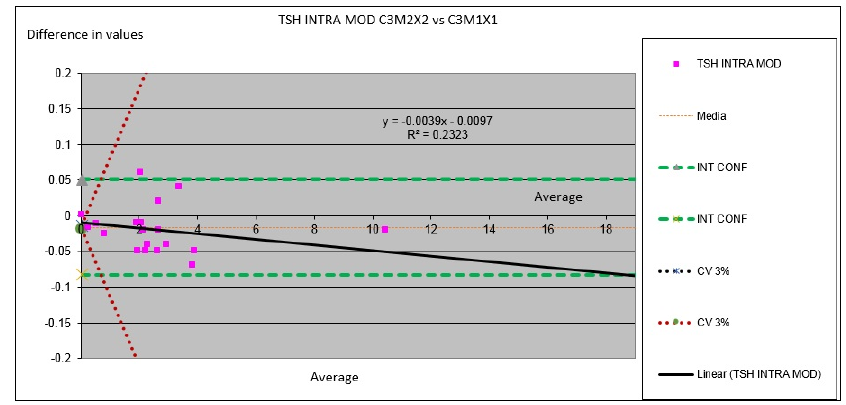
Figure 6. Comparison between modules for the TSH parameter in which it have compared the results obtained by the measurements performed in the two machines (Analyser C3 substituted by C2 in which the Module 2 is substituted by the module M1 and the channel X2 is substituted by the channel X1).